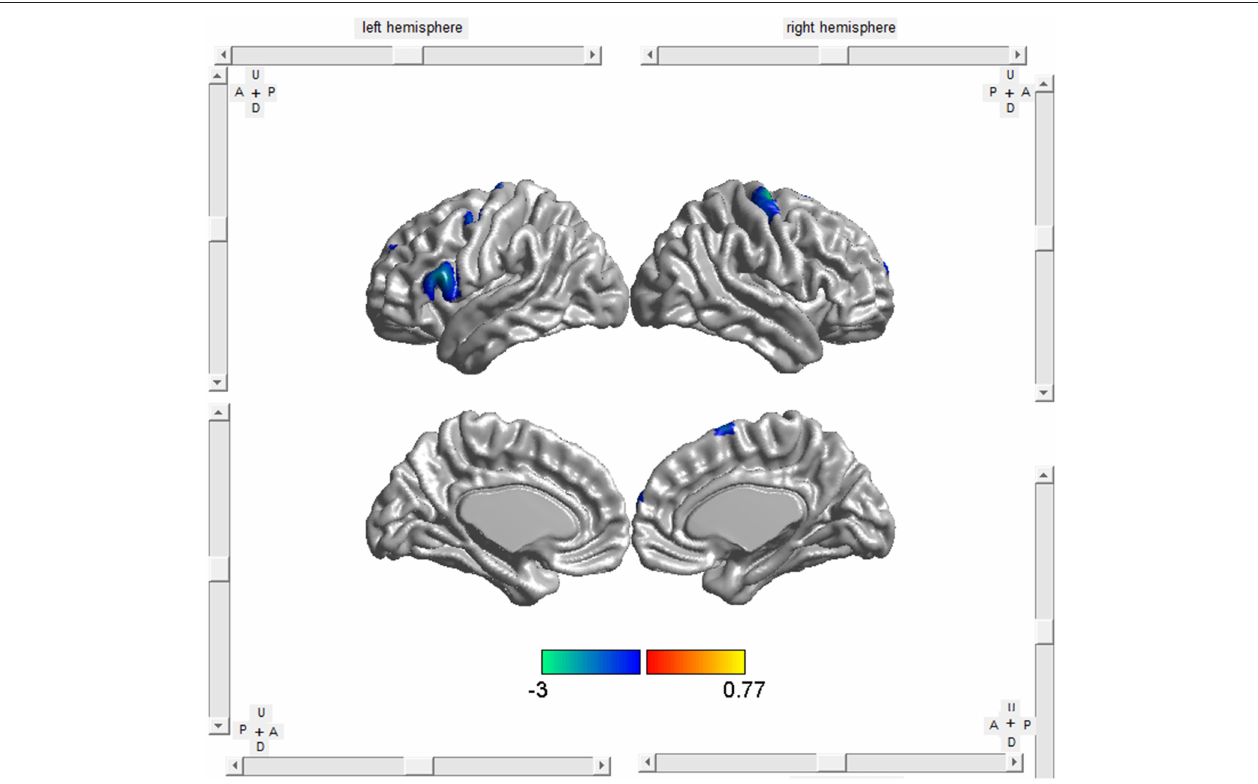
FIGURE 3 | Meta-regression analysis revealed that higher symptom severity was associated with more GM atrophy in the right precentral gyrus (BA 6) and the left inferior frontal gyrus (BA 44) in ALS patients.